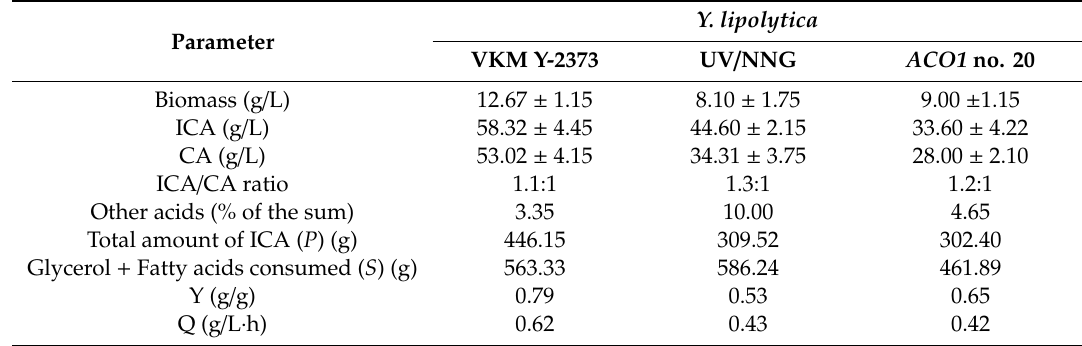
Table 1. Parameters of growth and (2 R ,3 S )-isocitric acid (ICA) production by Y. lipolytica strains.